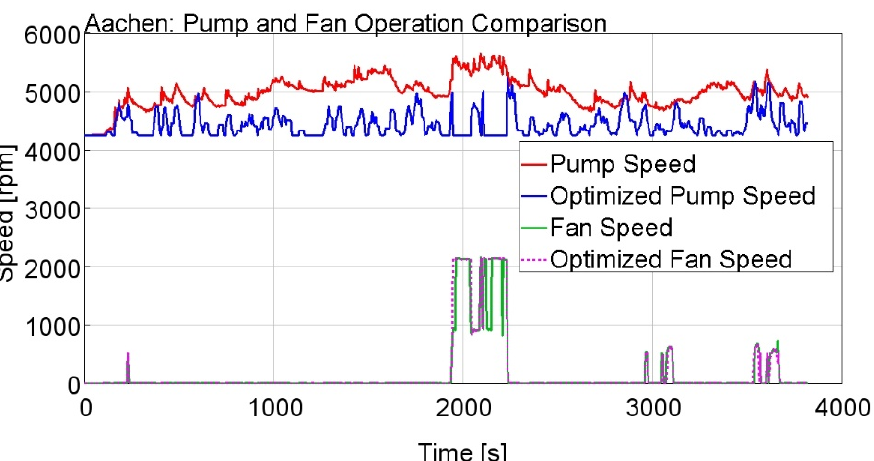
Figure 23. Control strategy comparison for single e-motor on Aachen driving cycle: coolant pump speed (top); radiator fan speed (bottom).